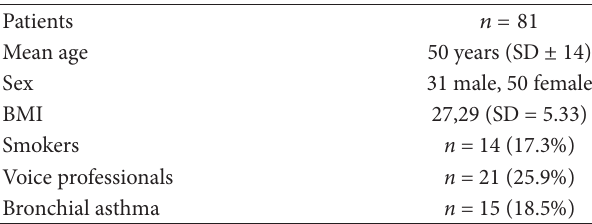
T 1: Characteristics of the study